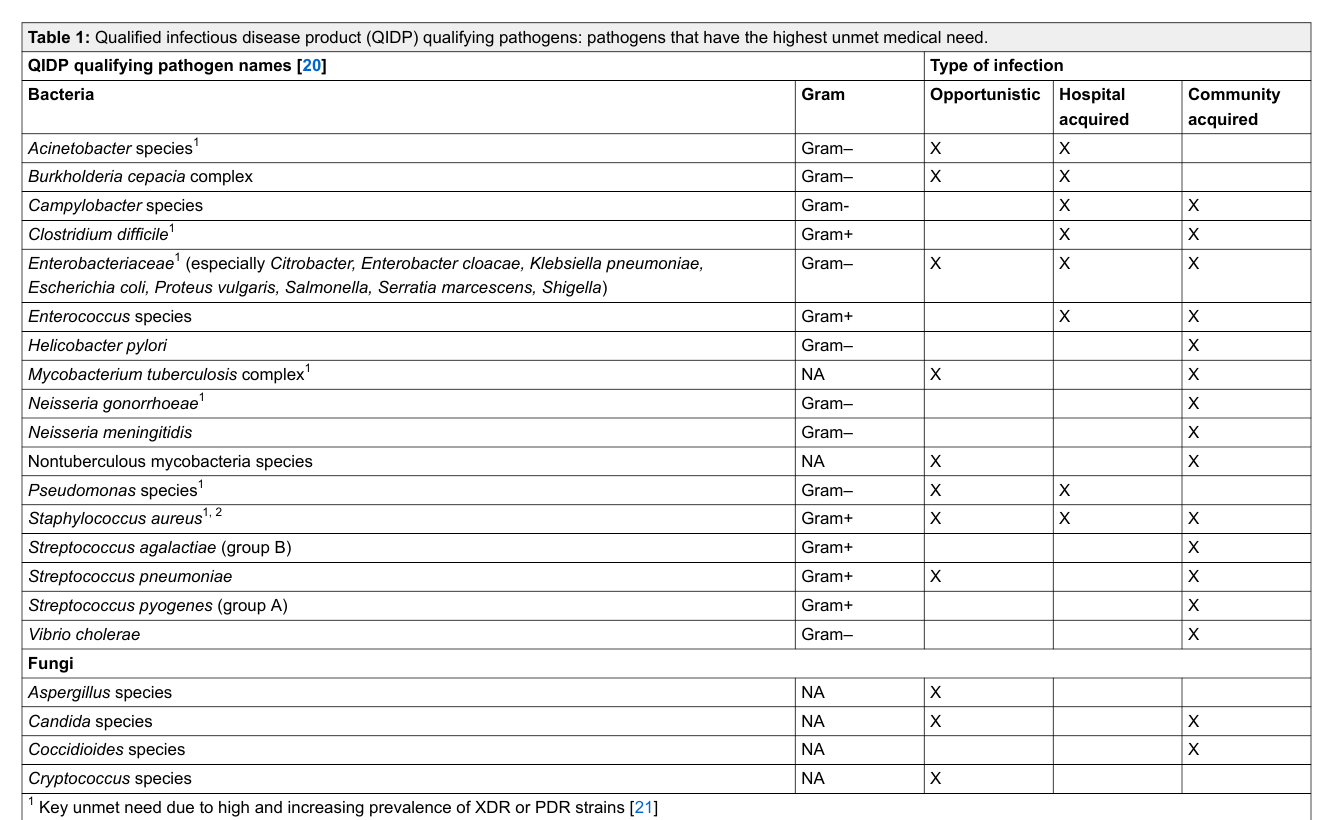
Figure 1 Essential determinants impacting the research and development (R&D) of new antibiotics. QIDP = qualified infectious disease product.